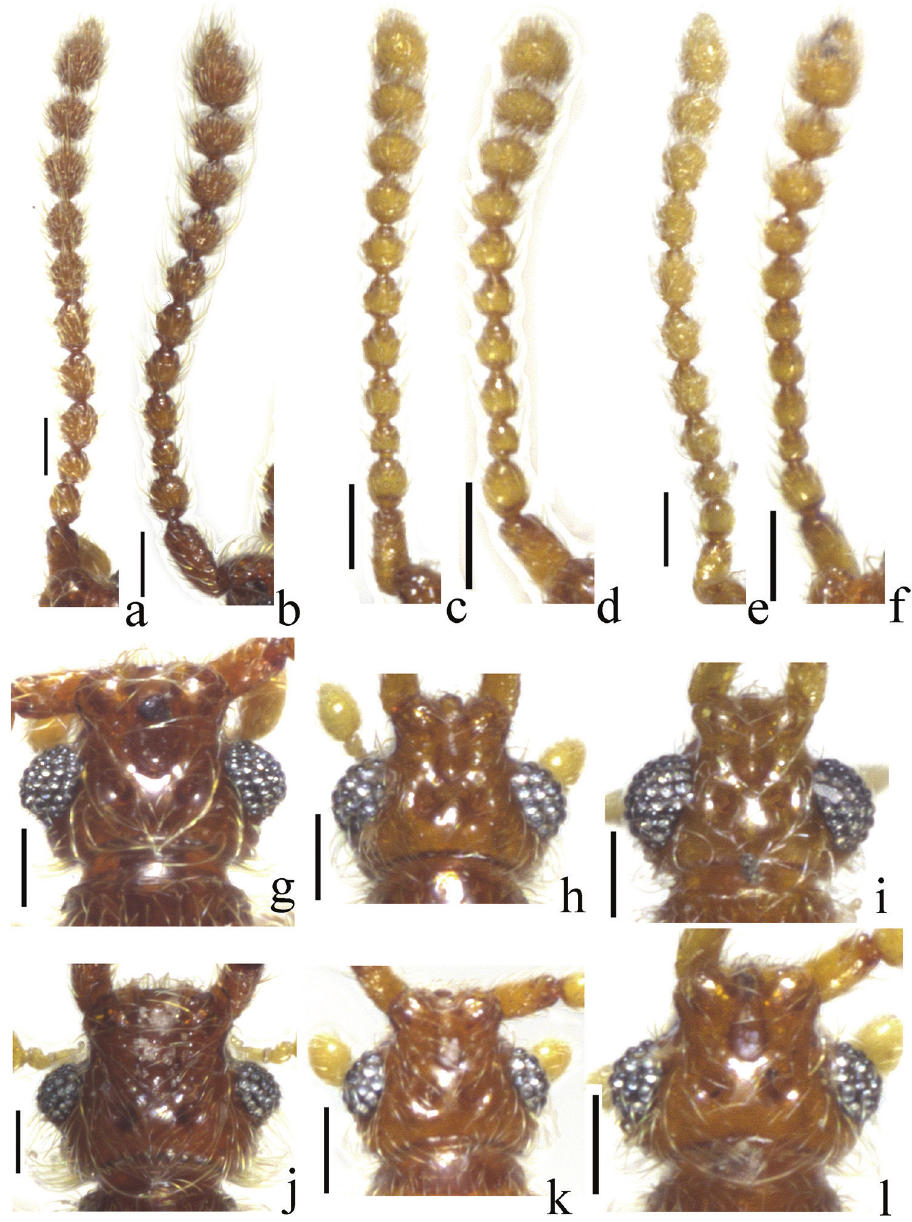
Figure 2. Antennae of Nornalup afoveatus sp. n. a male b female. Antennae of N. quadratus sp. n. c male d female. Antennae of N. minusculus sp. n. e male f female. Male heads, dorsal view g N. afoveatus sp. n. h N. quadratus sp. n. i N. minusculus sp. n. Female heads, dorsal view j N. afoveatus sp. n. k N. quadratus sp. n. l N. minusculus sp. n. Scale bars: 0.1